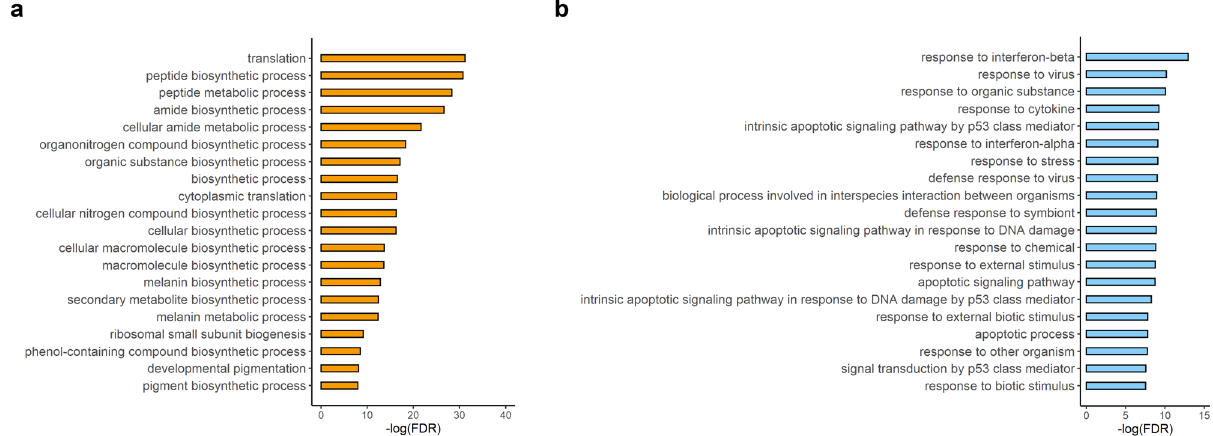
Fig. 5 Other Dox-related biological processes in the RPE based on upregulated and downregulated DEGs. a Bar graph showing the top 20 enriched GO terms for the upregulated DEGs in all clusters. b Bar graph showing the top 20 enriched GO terms for the downregulated DEGs in all